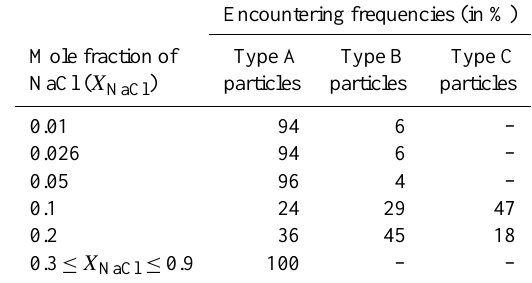
Table 1. Encountering frequencies (%) of type A, B, and C par- ticles, showing different mutual deliquescence behavior (details in text), at various mixing ratios of NaCl–MgCl 2